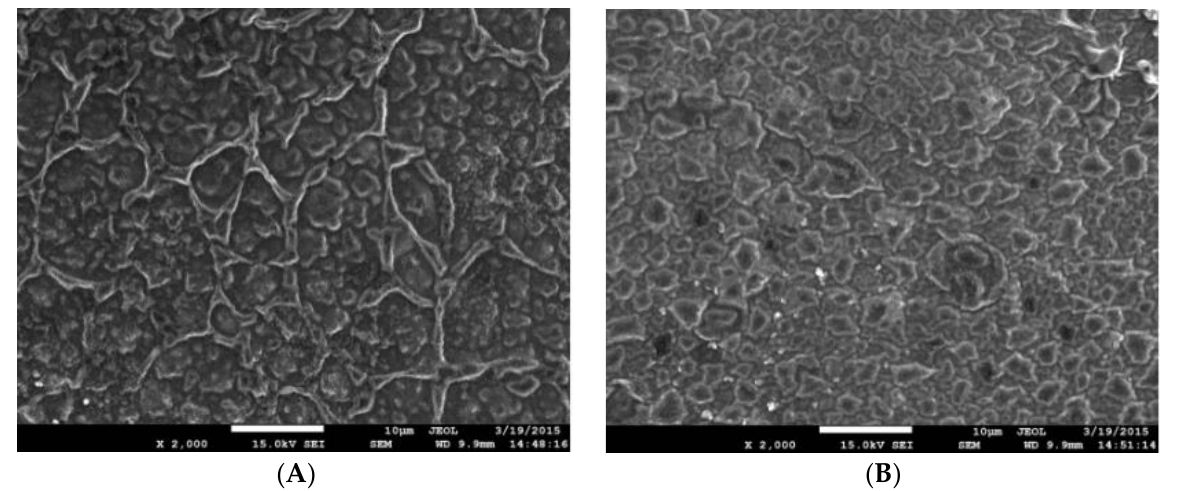
Figure 9. SEM images of soy protein/polyvinyl alcohol composite film (( A ) without TiO 2 , ( B ) with TiO 2 ) (material composition: 3.0% soy protein, 3.0% PVA, 2.0% glycerol, 1.5% PVP, 2.5% nano-TiO 2 ).